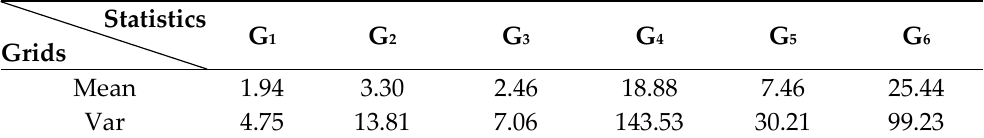
Figure 3. Mean and variance of tornados in every grid. Table 1. Mean and variance of the partial grid of annual tornado frequency.